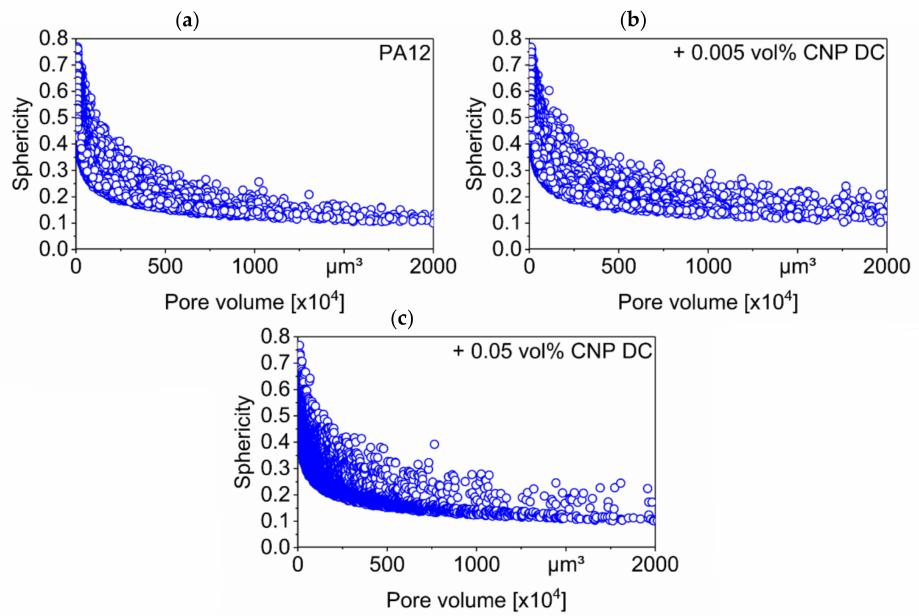
Figure 12. Sphericity measurements of the pores in specimens of ( a ) pure PA12, ( b ) PA12 dry-coated with 0.005 vol% CNP and ( c ) PA12 dry-coated with 0.05 vol%